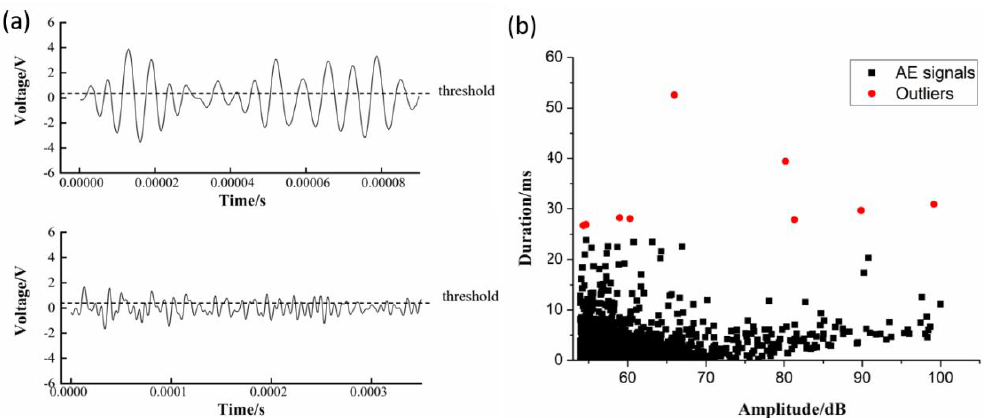
Figure 5. ( a ) Typical AE waveforms. ( b ) The relationship between amplitude and duration of the AE signals.